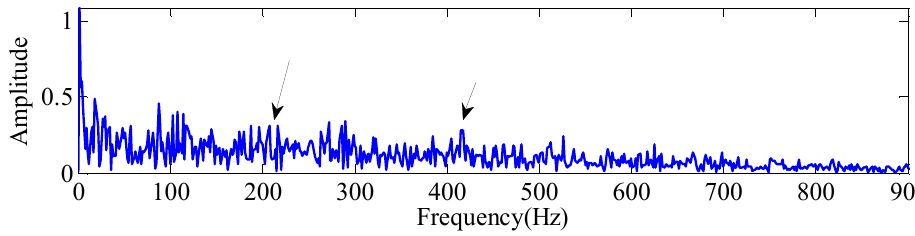
Figure 22. The envelope spectrum map of the randomly selected signal segments.